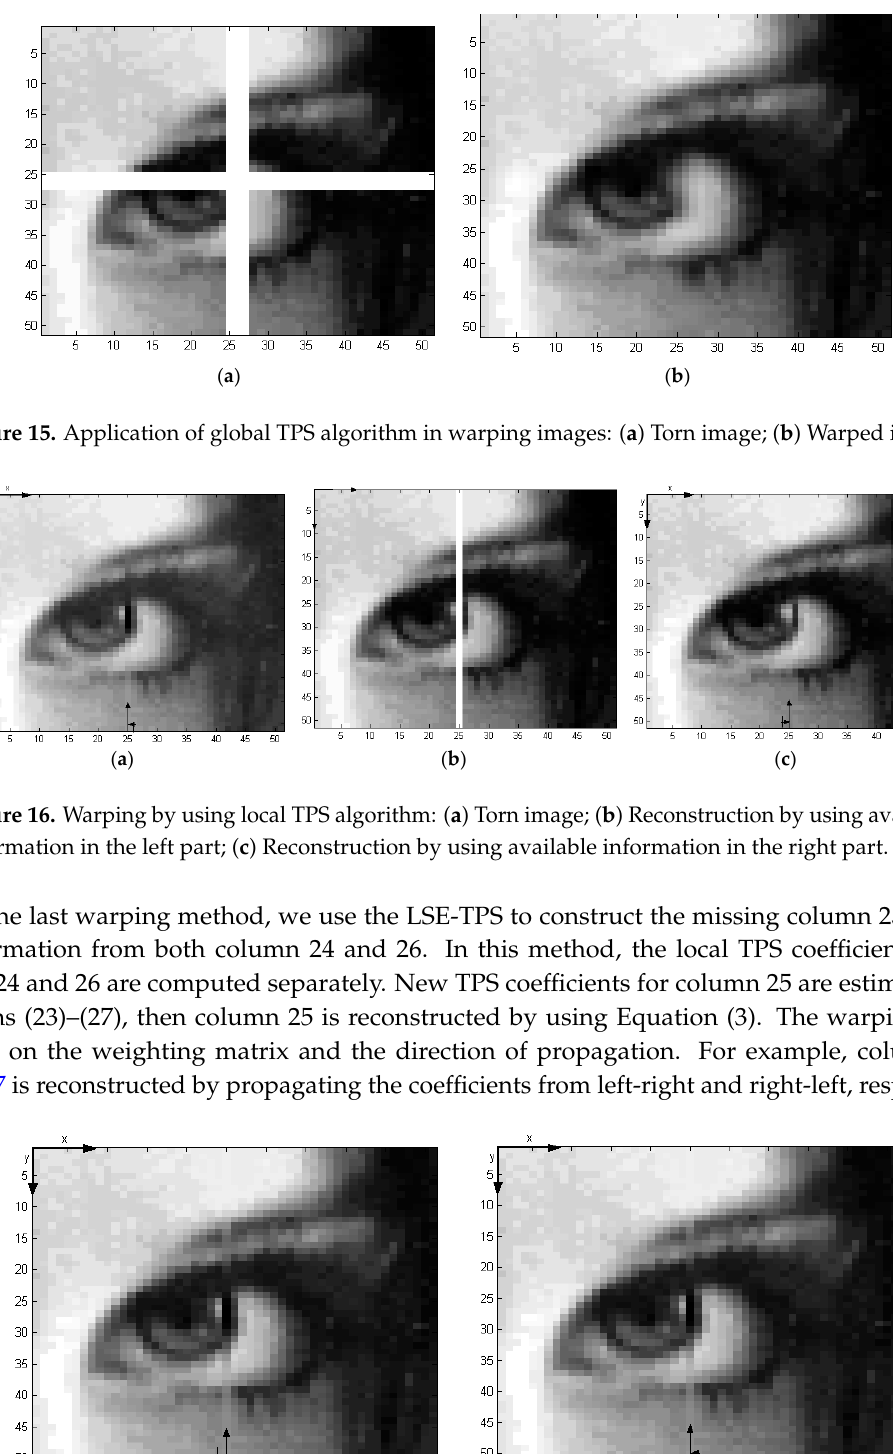
( c ) Figure 14. Reconstruction by using local TPS method: ( a ) A 50 × 50 Pixel 2 image is divided into 25 square windows; ( b ) Reconstructed image at resolution of 100 × 100 Pixel 2 ; ( c ) Reconstructed image at resolution of 250 × 250 Pixel 2 . Figure 15a shows an image torn into four pieces, where the white area refers to the missing control points whose spatial locations ( x , y ) are known. The goal is to warp the pieces into a single image by using global modified TPS, local modified TPS and LSE-TPS methods. First, in the global